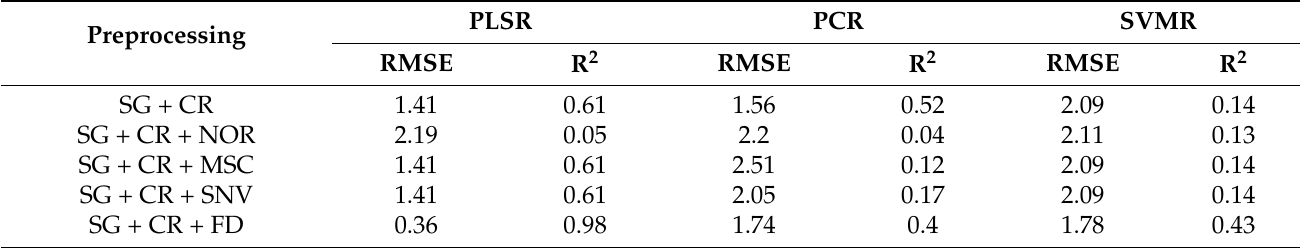
Table 6. Determination accuracies of Ni concentrations based on spectral bands associated with